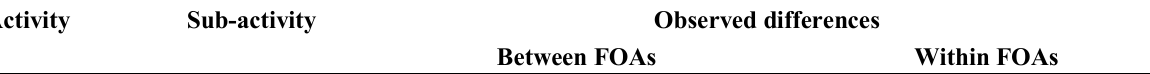
Table 4. Observed differences in activities included in the Harvest wood function between and within the two case